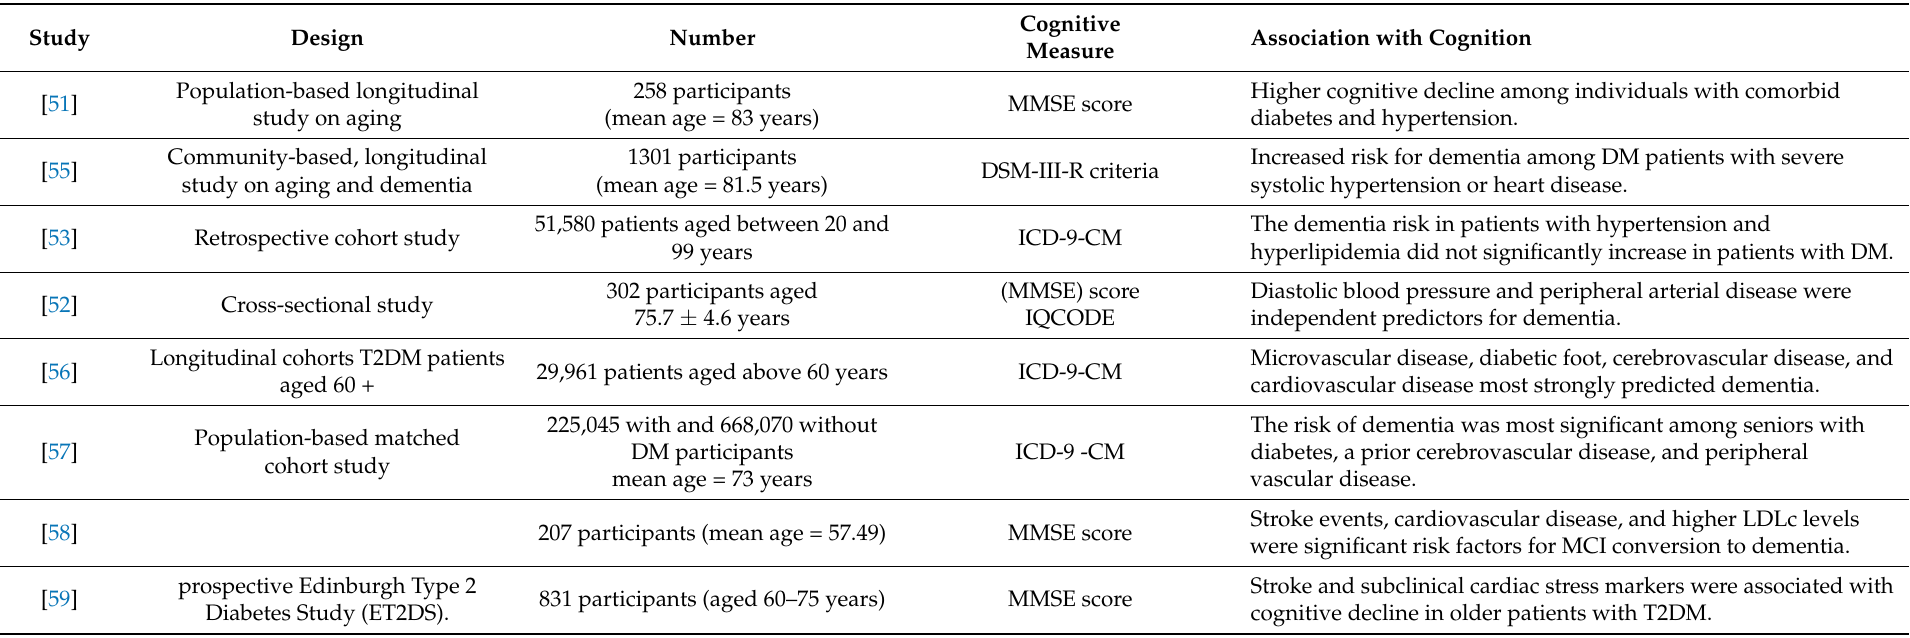
Table 2. Studies showing the relationships between vascular risk factors and cognitive function in patients with